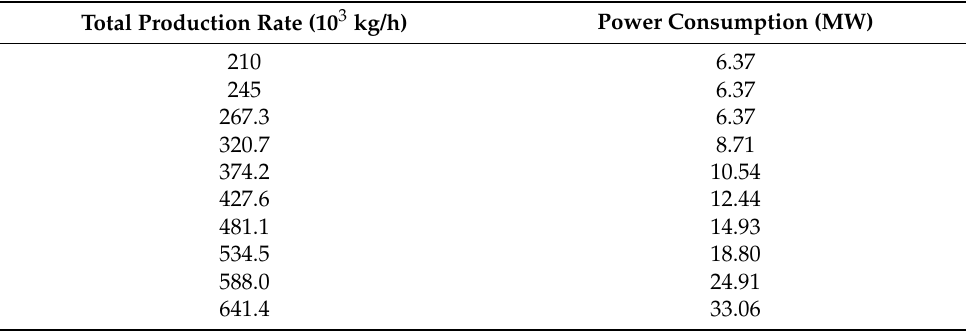
Figure 3. Total power consumption versus total production. Table 2. Total production rate and power consumption of the